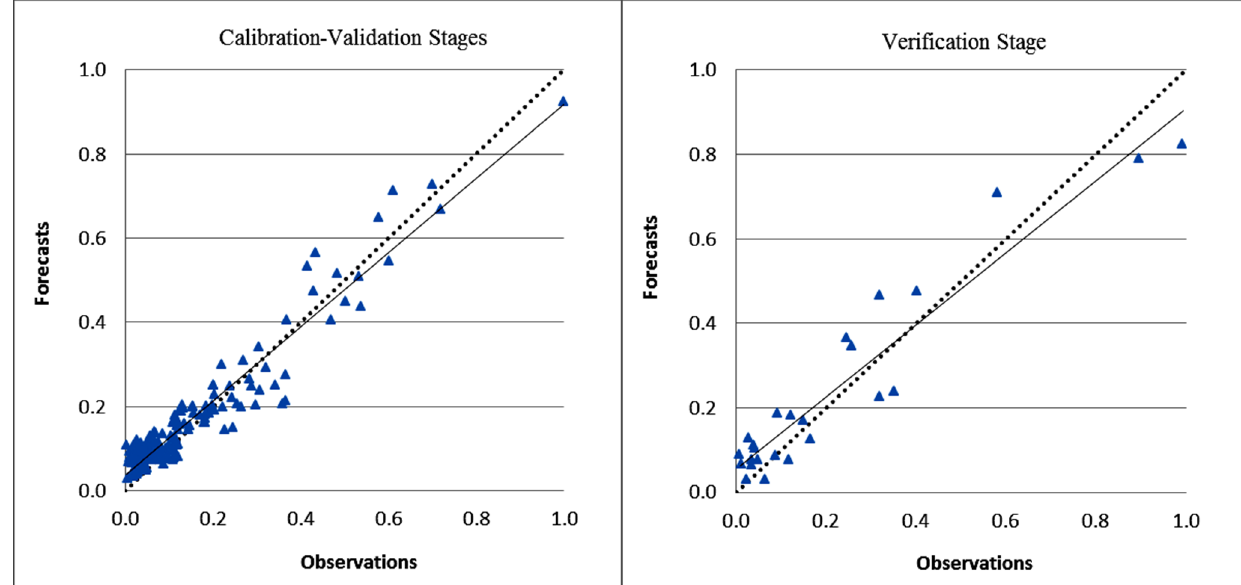
Figure 6. Final results of standardized forecasts vs. standardized observations using the NARX-ANN method.